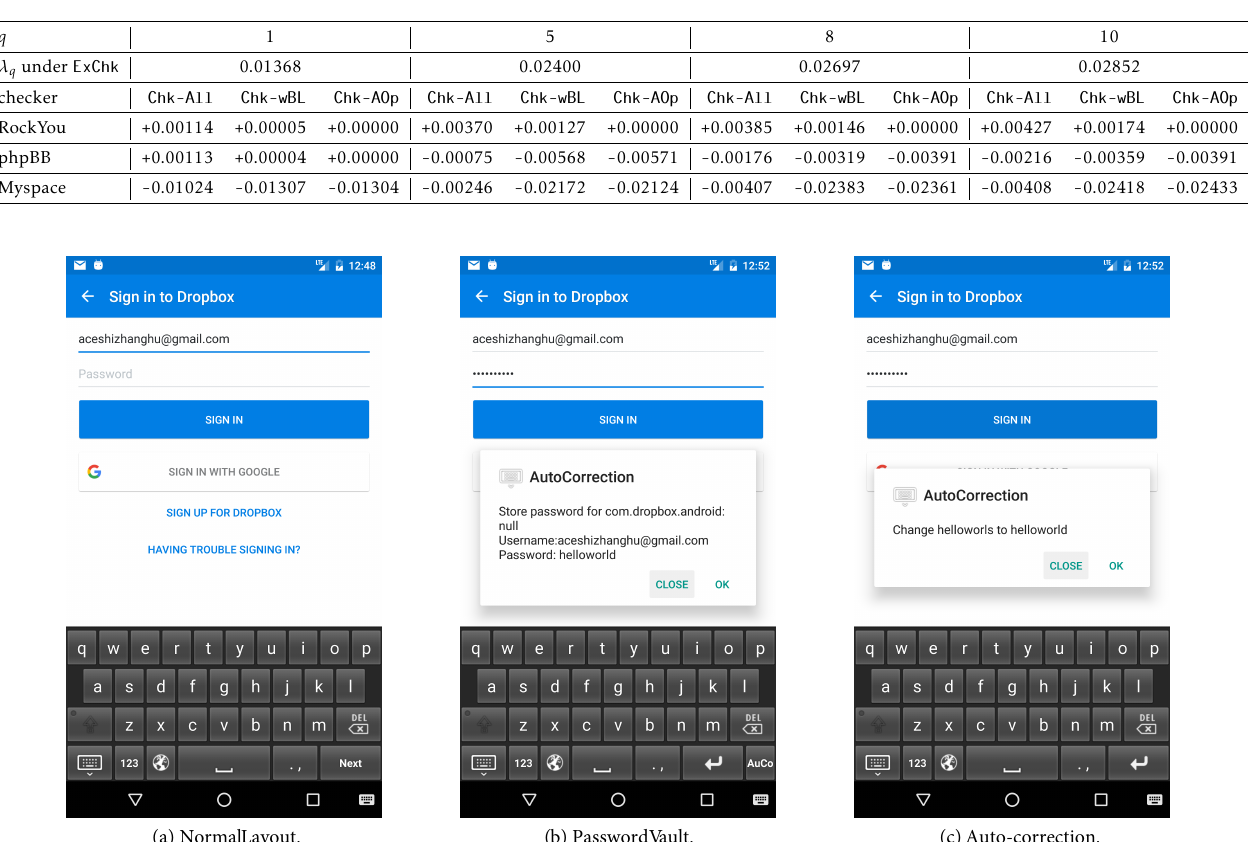
Figure 1. Security loss measuredfor di˙erentcheckersand query numbers.Note that the securityloss for Chk-AOp is zero, so we omitit forthe sake of fin typography. Table 4. Security loss measuredagainst attackerswithestimatedpassworddistributions.The challengedistributionis fi ed to be the RockYou database. To showthe worsecase security,we used C top 4 as the transformationfunctionset.